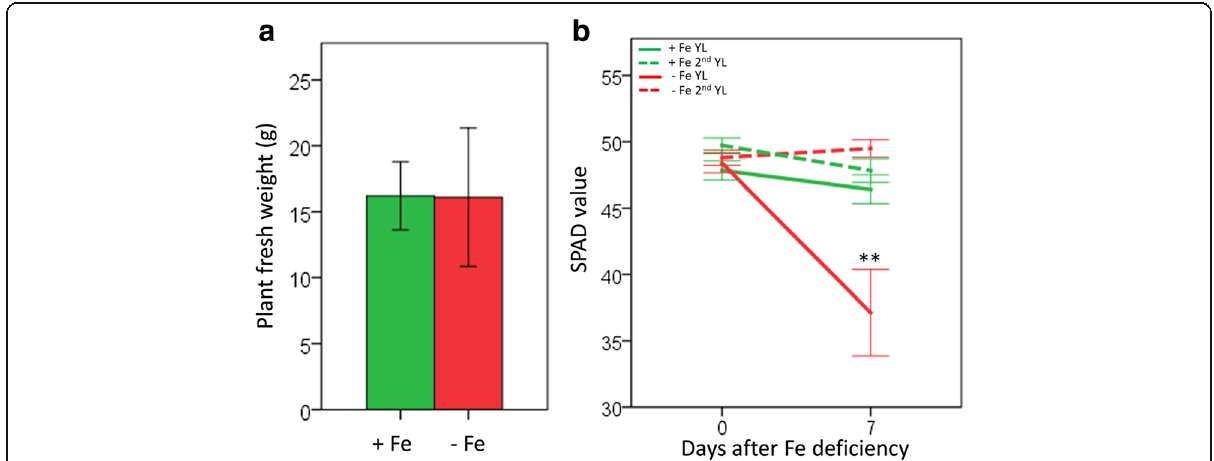
Fig. 1 Induction of Fe deficiency symptoms in rice plants. a Plant fresh weight ( n = 9). b SPAD values of the youngest leaf (YL) and 2 nd youngest leaf (2 nd YL) ( n = 30). Plant fresh weights and leaf SPAD values of Fe-sufficient ( green ) and Fe-deficient ( red ) plants were measured at 0 and 7 days after the Fe deficiency treatment. Values are presented as means±SE of n biological replicates. Significant differences are indicated by ** for p <0.01 by Student ’ s t-tests performed between treatments within leaf types and days after Fe